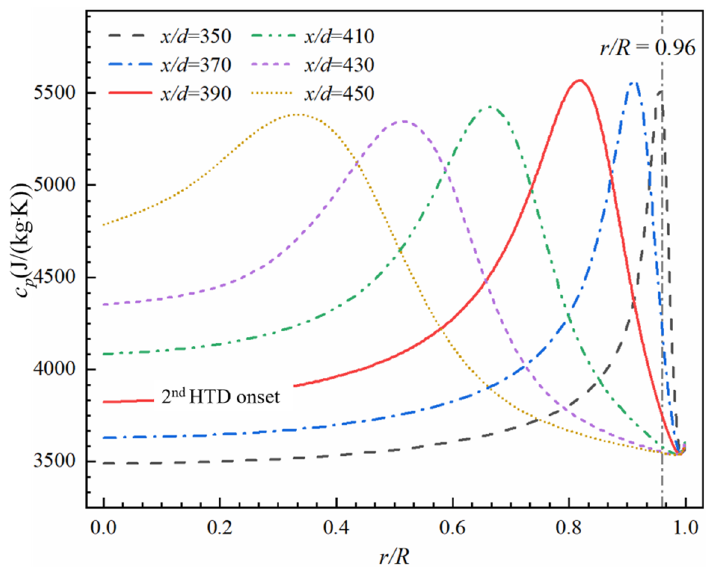
Figure 12. Radial distributions of specific heat capacity in the second HTD zone.